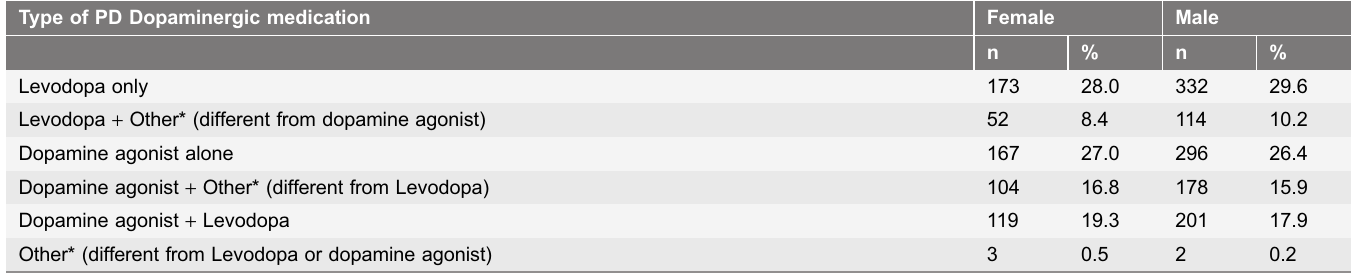
Table 1. Type of PD dopaminergic medication use at baseline: descriptive statistics and test. Type of PD Dopaminergic